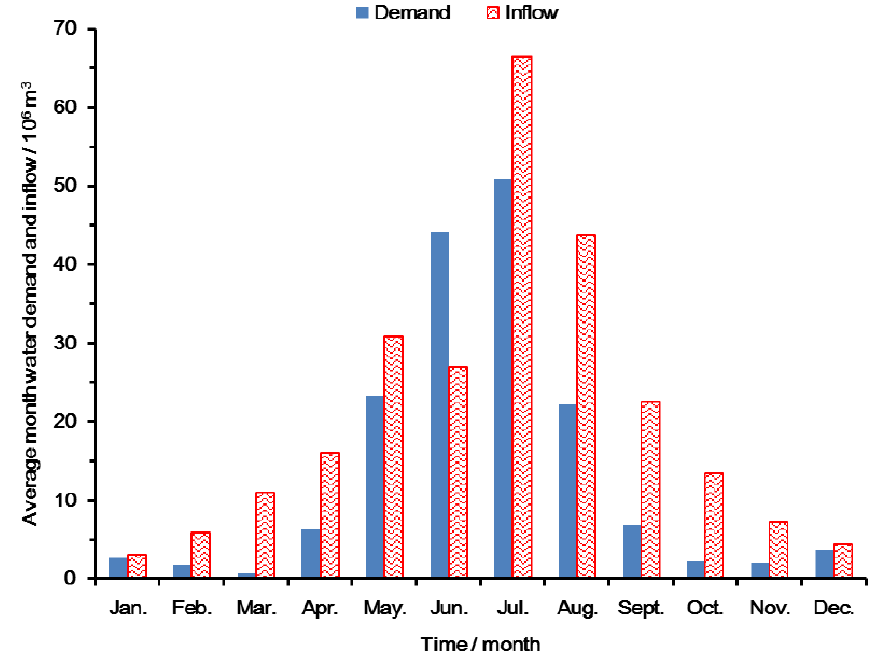
Figure 8. The monthly average inflow into Xujiahe reservoir and the monthly average water demand of agriculture.